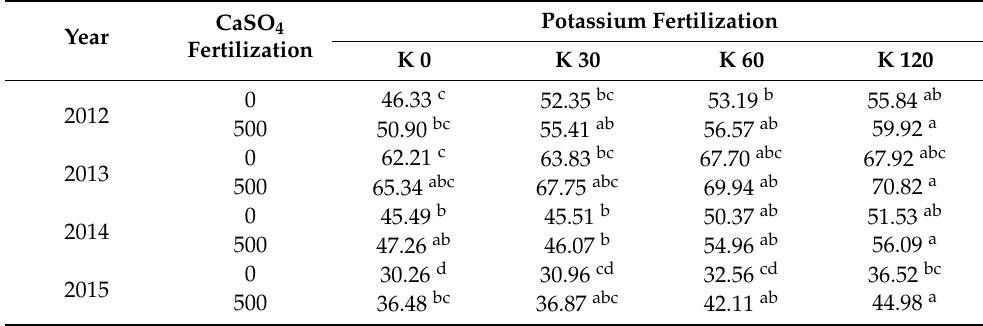
Table 3. Effect of CaSO 4 application and varying doses of potassium fertilization on sward yields of alfalfa-grass mixtures (t ha − 1